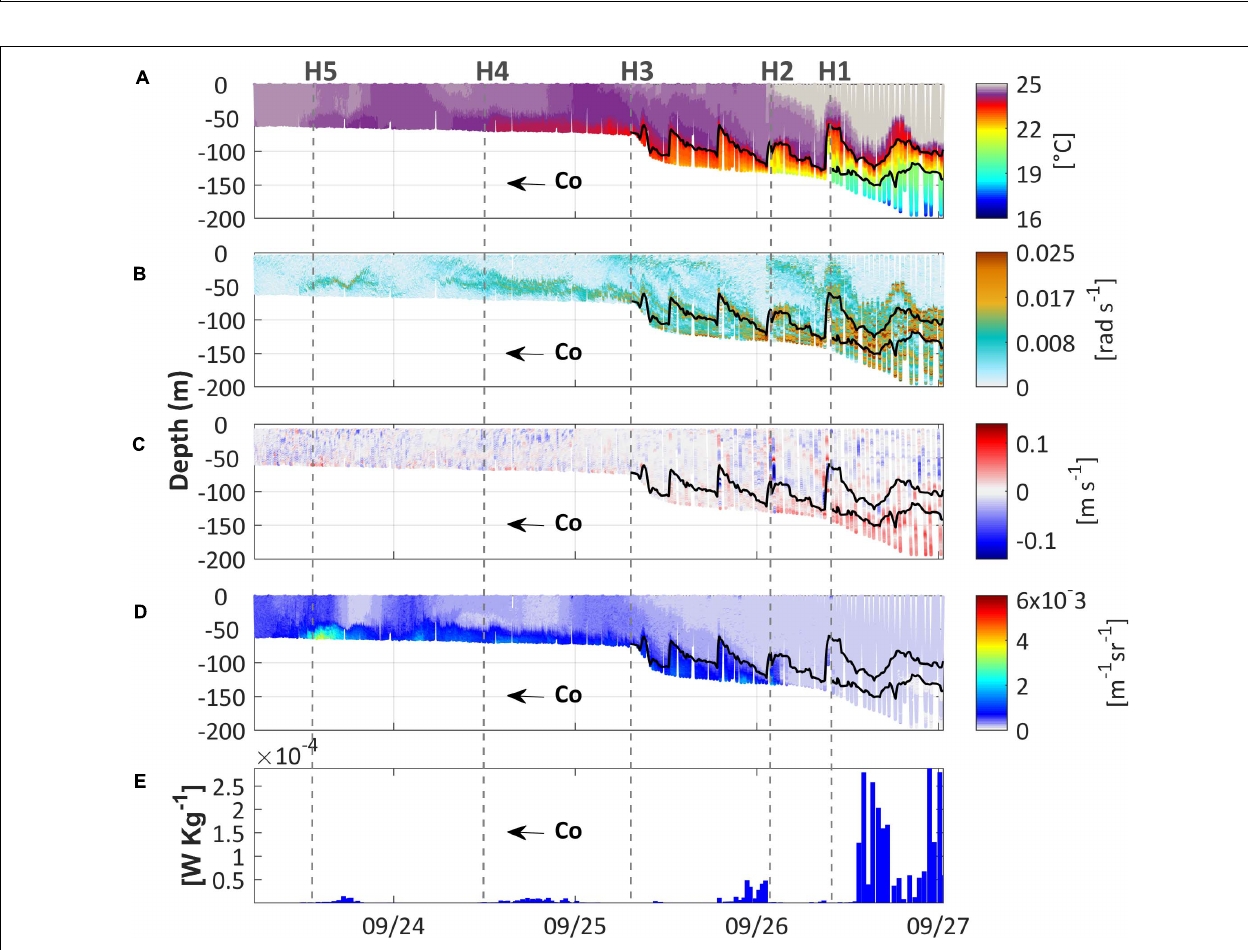
FIGURE 13 | Ocean glider cross-section profiles obtained on September 2013: (A) temperature; (B) Brunt-Väisälä frequency; (C) vertical water velocity calculated from downcast profiles; (D) volumetric backscatter coefficient (VBSC); and (E) the root-mean-square of the rate of turbulent mixing (in W Kg − 1 ) throughout the water column. In (A–E) c o indicates the shoreward wave propagation direction. The gray vertical dashed lines identify features referred to in the text. The 20 and 23 ◦ C isotherms are displayed on each panel (black solid